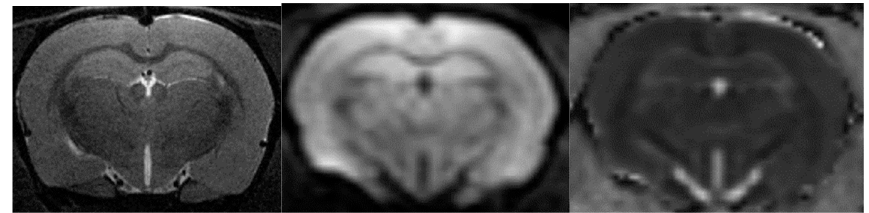
Figure 16. From left to right are images of T2-WI, DWI,